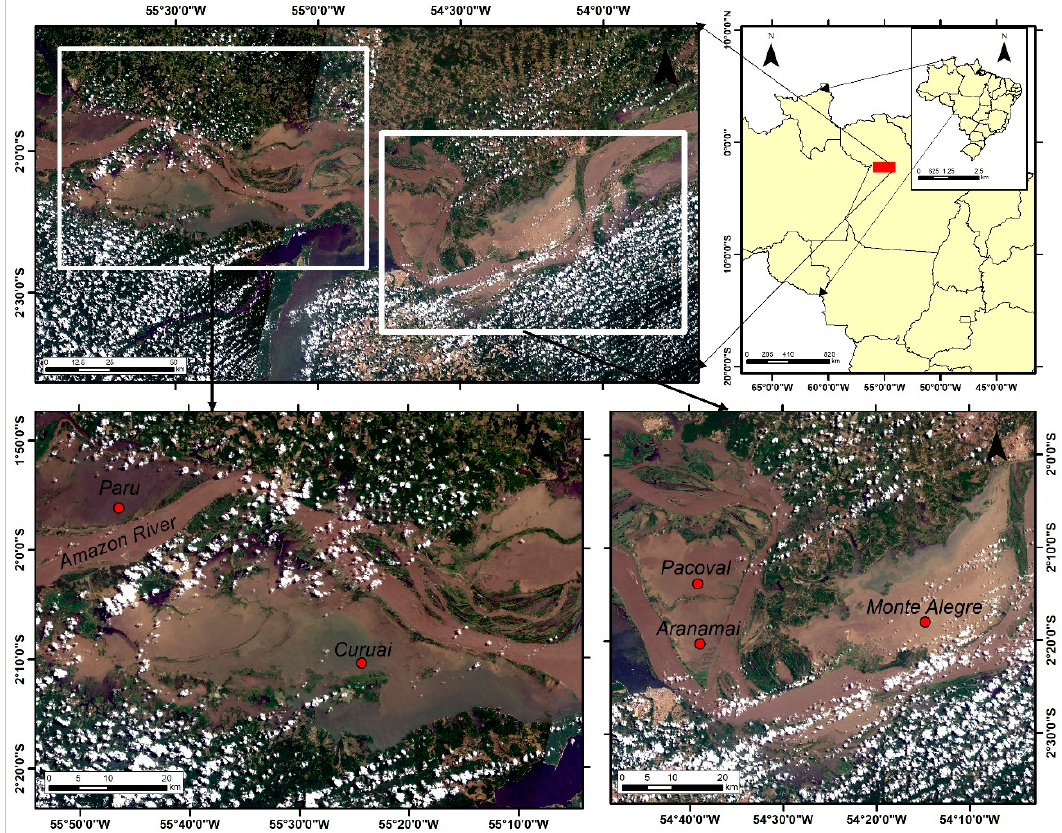
Figure 1. The study area: The red points refer to lakes where the field campaigns were conducted. The True Color R4G3B2 composition was derived from OLI imagery. The bottom-left box refers to an OLI imagery from Aug/10/2017m and the bottom-right box refers to an OLI imagery from Aug/19/2017. Image source: United States Geological Survey (USGS). The coordinates are in the Geographic Coordinate System DATUM SIRGAS 2000.